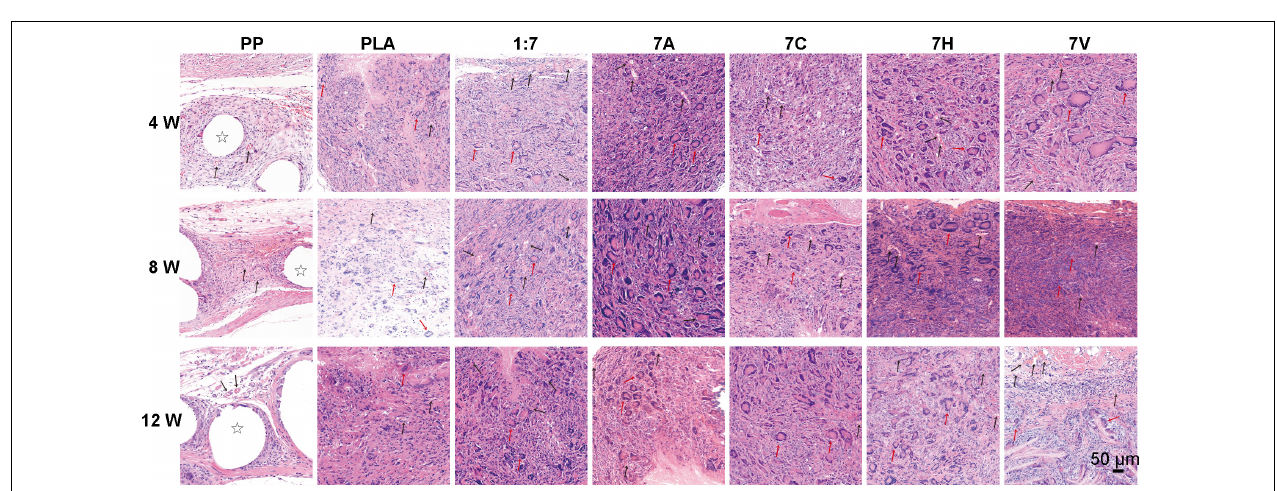
FIGURE 4 | The analysis of abdominal adhesion scores after 4, 8, and 12 weeks of implantation. * P < 0.05 vs. the PP and PLA groups.